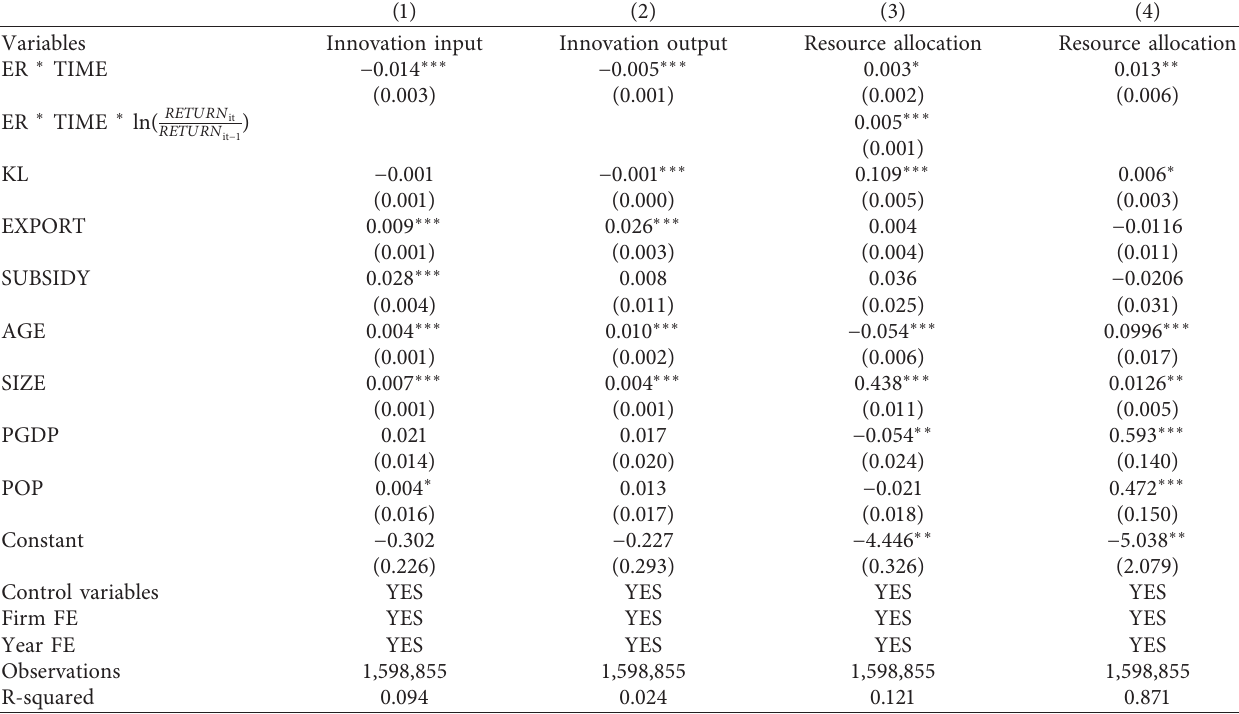
Table 5: Mechanism regression results.